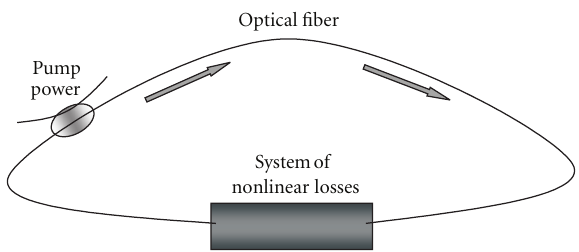
Figure 1: Schematic representation of the investigated ring passive mode-locked fiber